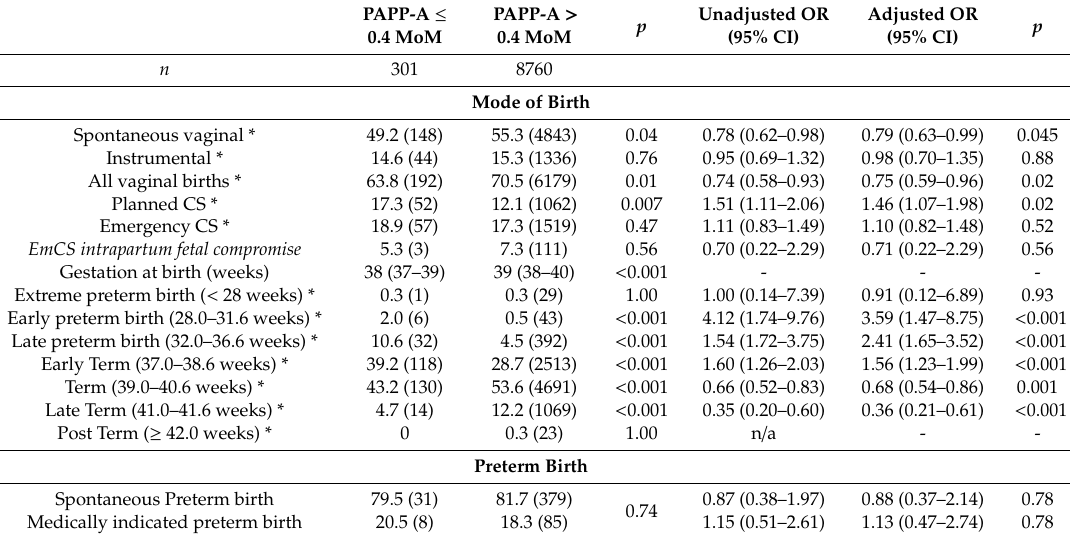
Table 2. Intrapartum outcomes.